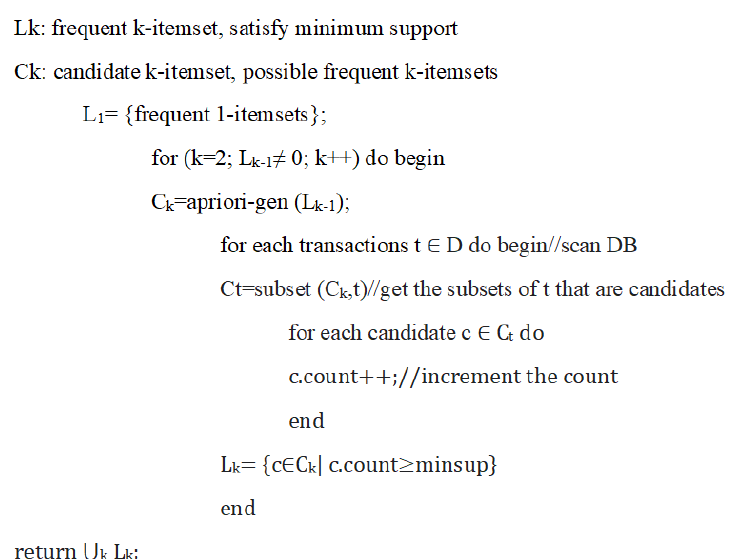
Figure 3. The pseudo code of the Apriori algorithm.